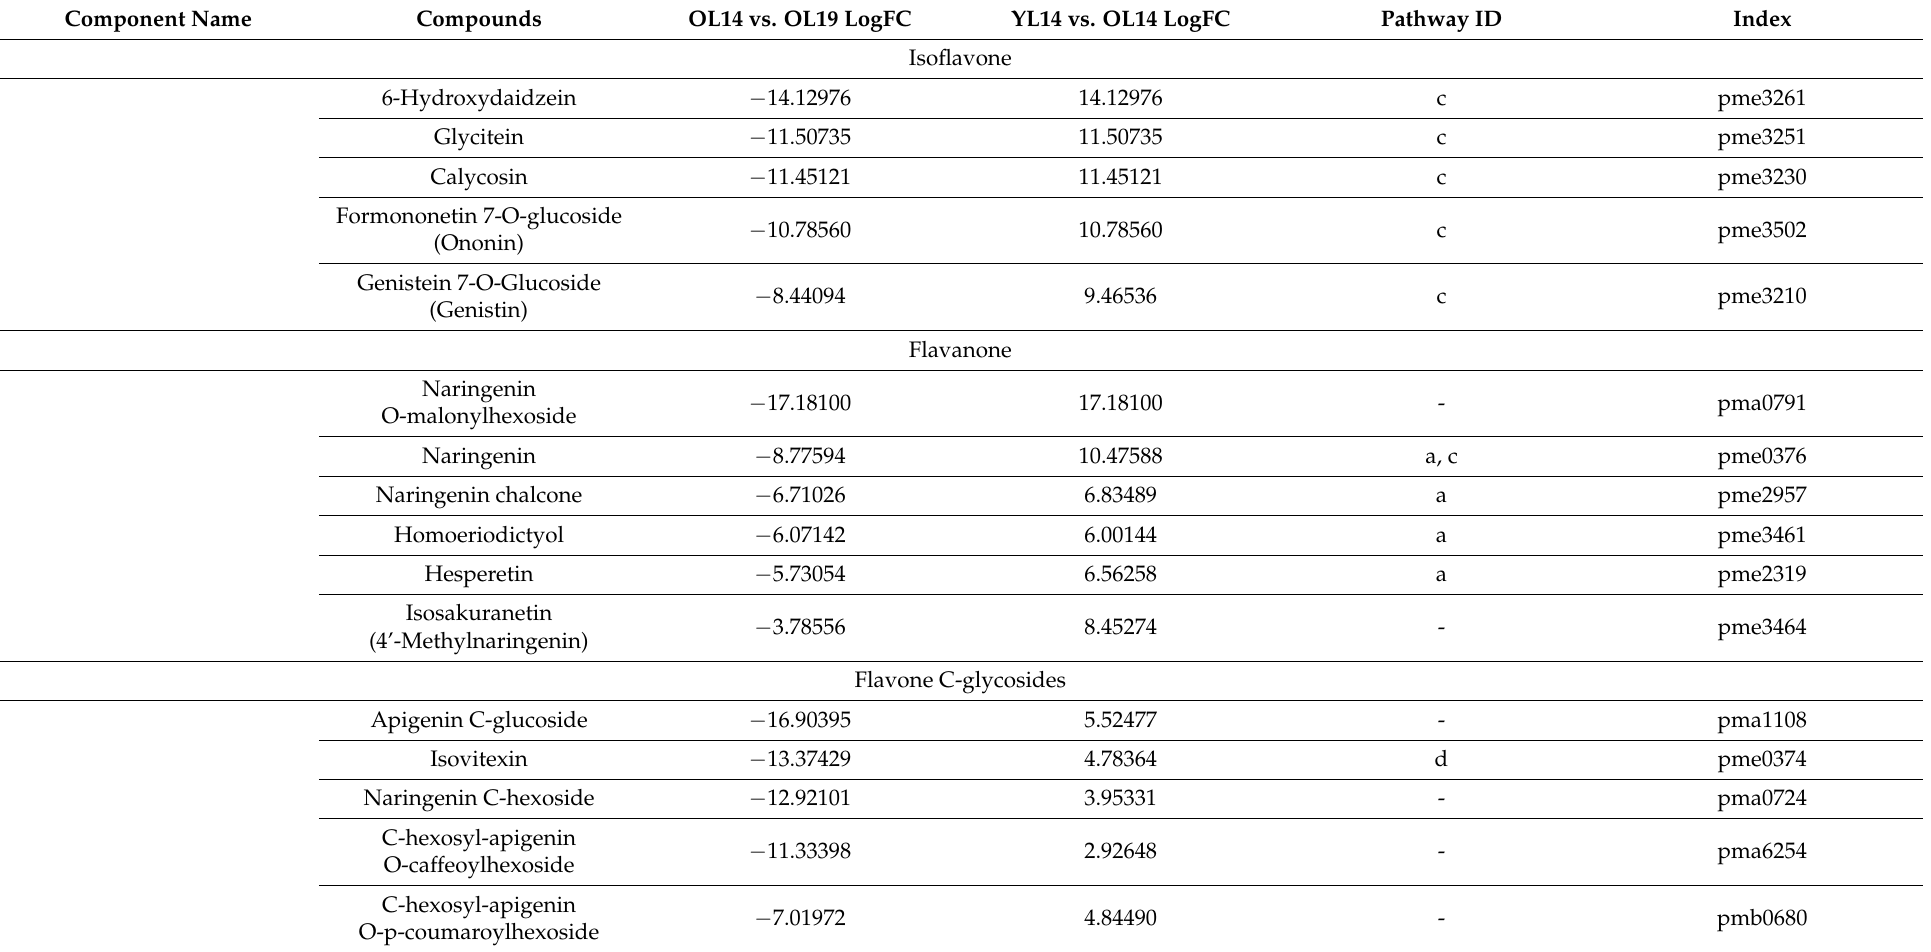
Table 1. The differentially accumulated flavonoids (DAFs) related to peel yellowing in L14 and